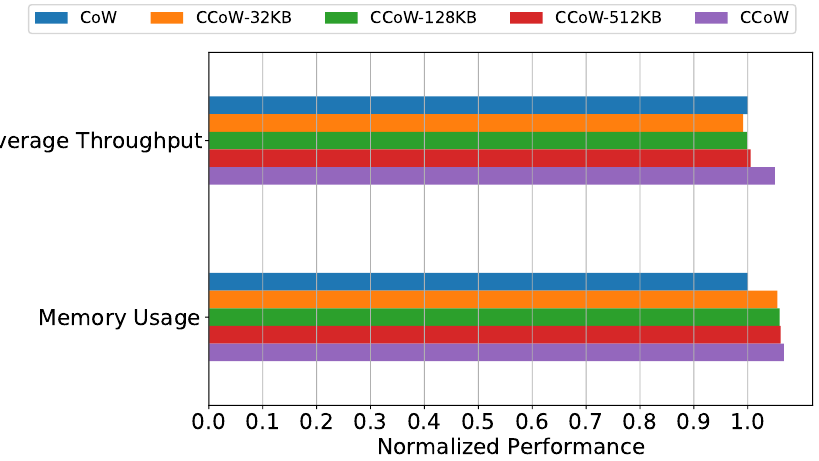
Figure 3. The performance and overhead of CCoW for various region